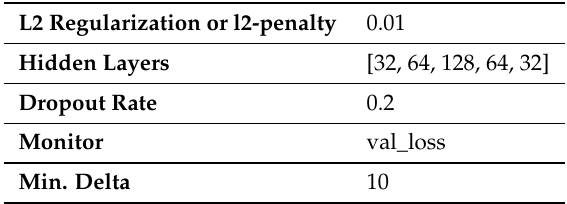
Table 1. 1D-CNN’s hyper-parameters to classify activities.